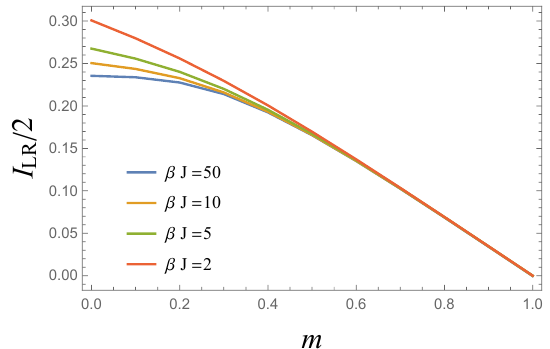
Figure 6. Renyi-2 mutual information I (2) (Ψ( m )) between the left system and the unmeasured LR Majorana fermions on the right side. m = M/N is the ratio of measured Majorana fermions on the right side. The mutual information is always non-vanishing for m < 1 , and vanishes only when the whole right side is measured ( m = 1